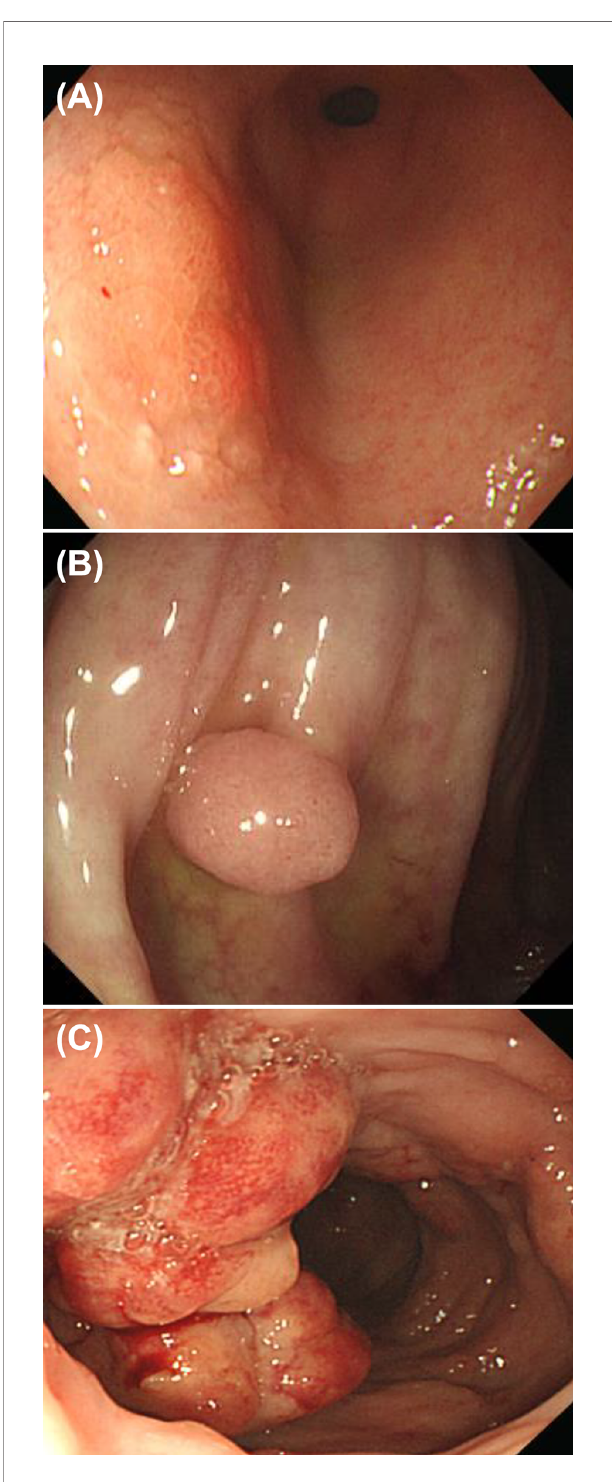
FIGURE 2 | Gastrointestinal tract malignancy in patients with primary immunode fi ciency (A) Early gastric carcinoma in a patient with CTLA4 de fi ciency. (B) Colonic tubular adenoma in a patient with common variable antibody de fi ciency. (C) Colonic MALT lymphoma in a patient with activated PI3K d